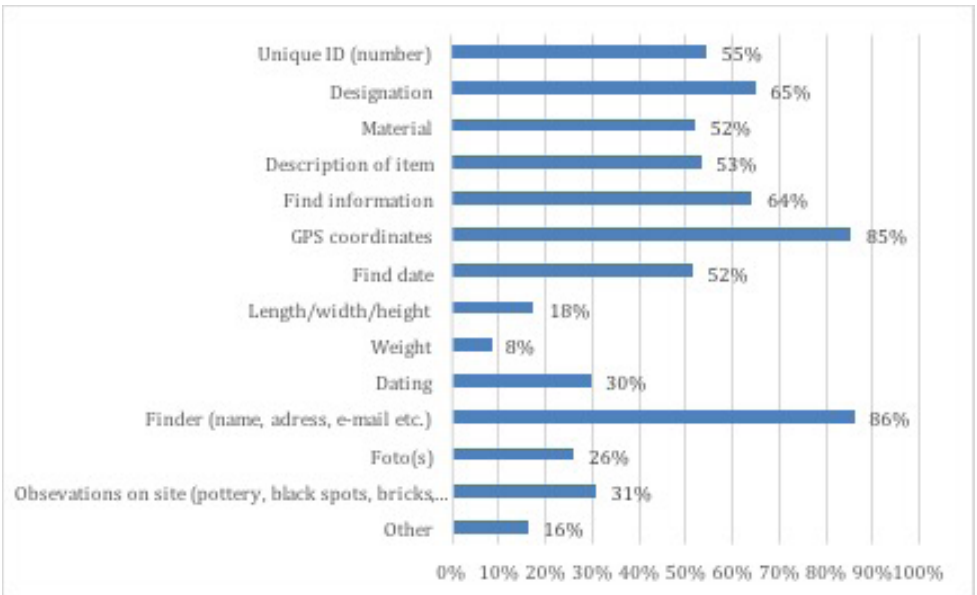
Figure 6: Results of the ‘2015 Danish detectorists survey’. Detectorists were asked which type of data they record and share with their respective local museums when handing over finds.